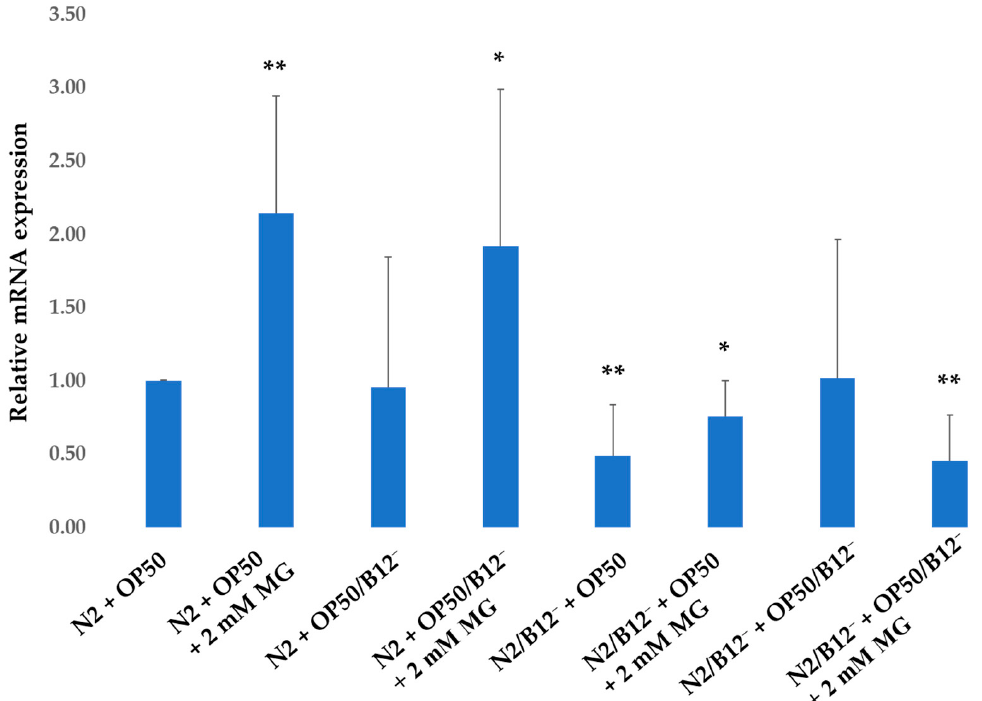
Figure 7. Expression of lrp-1 gene on N2 and N2/B12 − worms fed with either OP50 or OP50/B12 − with or without 2 mM mogrosides (MG). The fold-change (2 − ∆∆ Ct ) and standard deviations of the gene expression were calculated from five independent experiments. All treatments were compared to the N2 + OP50. The Student t -test was conducted to assess the statistical significance (* p < 0.05; ** p < 0.01).